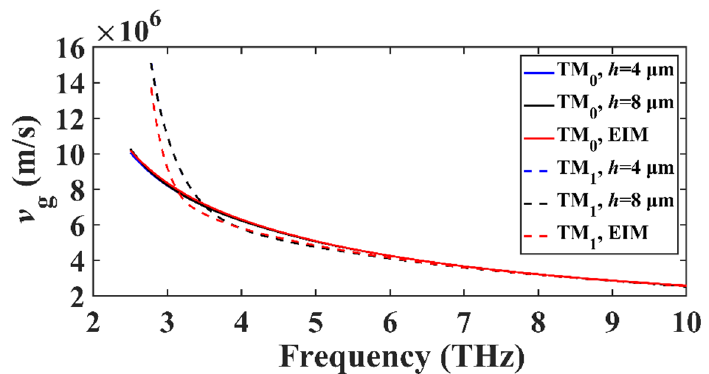
Figure 5. ( a ) Real and ( b ) imaginary parts of the effective mode indices of the TM 0 and TM 1 modes in DLGSPWG with respect to the wavelength at different strip heights. w = 4 μ m, E F = 0.6 eV. Note that the blue and black lines nearly overlap each other. Solid lines and pink squares for TM 0 , dashed lines and green squares for TM 1 .